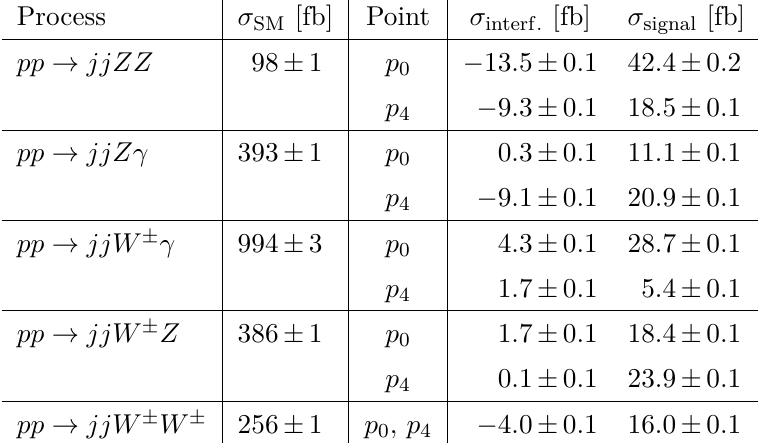
Table 2 . EW VBS SM background and ALP signal partonic cross sections for decaying the vector bosons and applying only the selection cuts in eq. (4.1). The ALP signal cross sections are presented for two benchmark points p 0 and p 4 defined in eq. (4.2). For same-sign W ± W ± , both points give the same results. The reported errors are the statistical errors of the